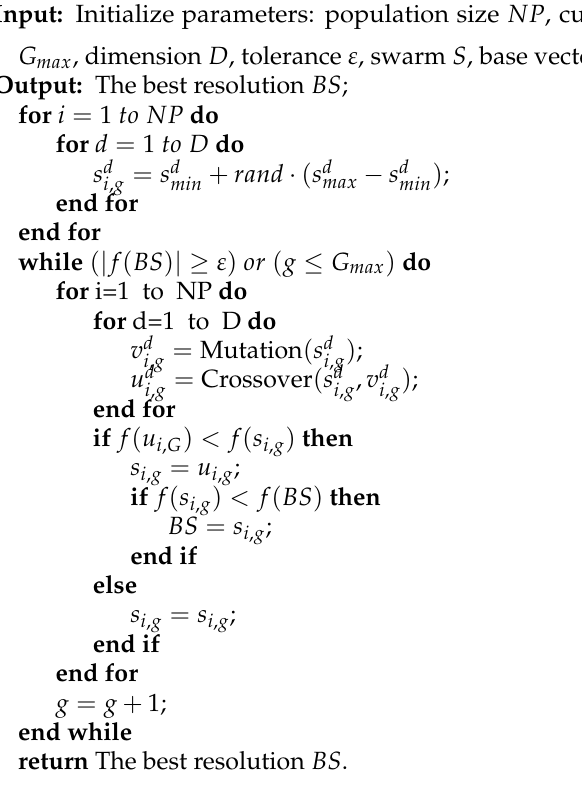
Algorithm 2 The DE Algorithm